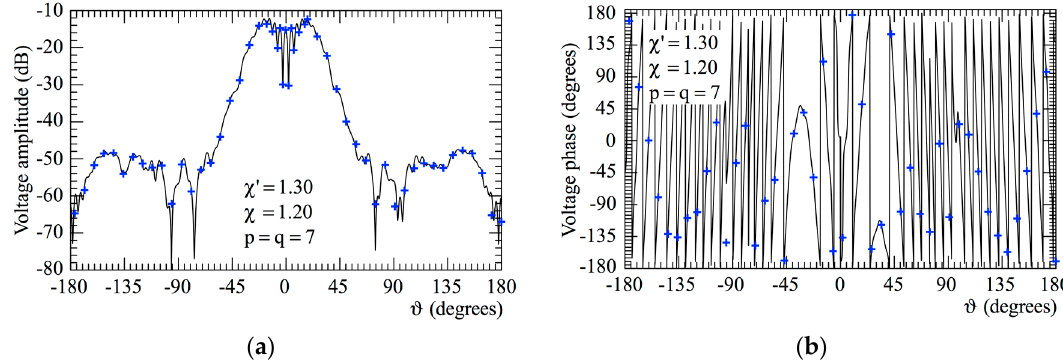
Figure 8. p V on the meridian at ϕ = 90°. ――― reference. + + + + interpolated from the non-redundant measurements: ( a ) amplitude; ( b ) phase.